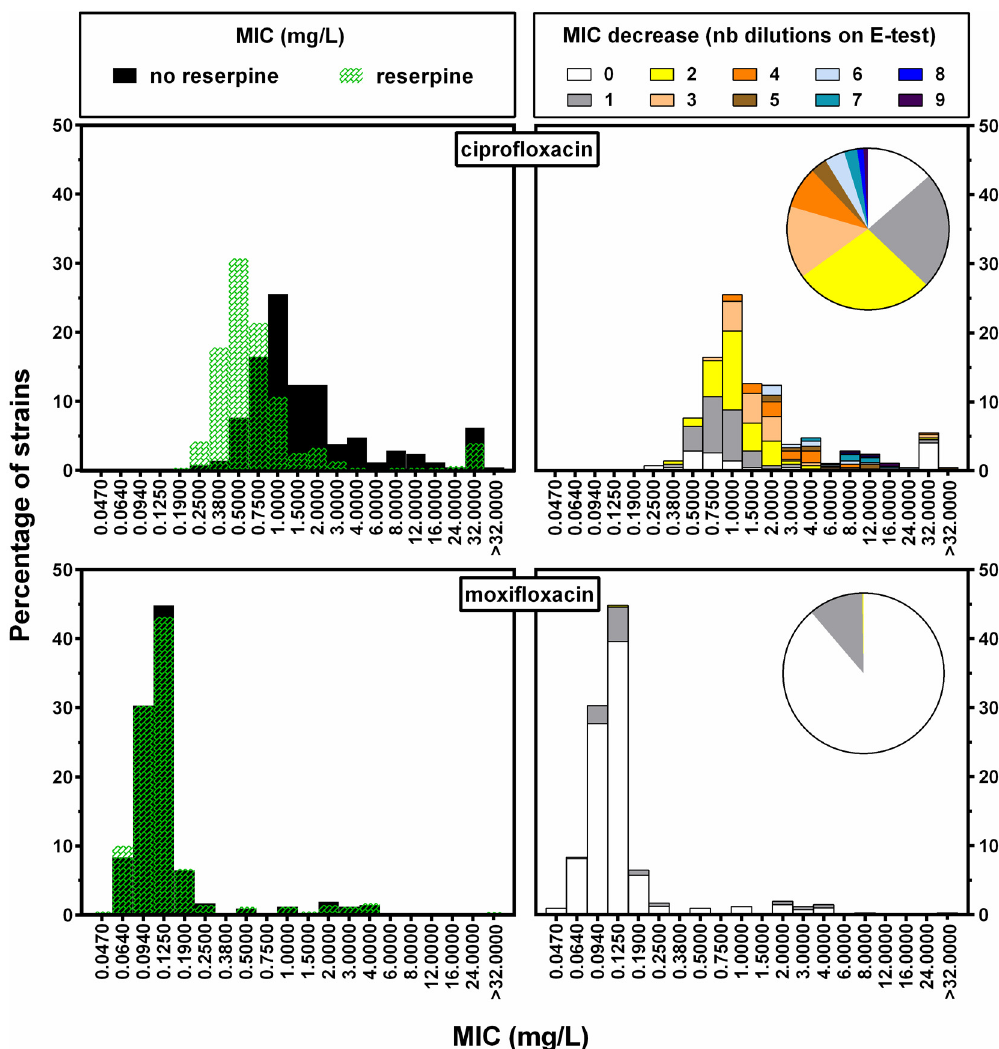
Fig 2. MIC distributions of ciprofloxacin and moxifloxacin (E-test method) for 422 non-invasive S . pneumoniae isolates collected in Belgium between 1995 and 2014. Left-hand panels: MIC distributions determined in the absence (control; black) or presence (green) of 20 mg/L reserpine. Right-hand panels: reduction of MIC (in blocks of 0.5 log 2 dilutions from 0 to 3 log 2 dilutions) after addition of 20 mg/L reserpine and plotted as a function of the MIC distribution of the isolates in the absence of